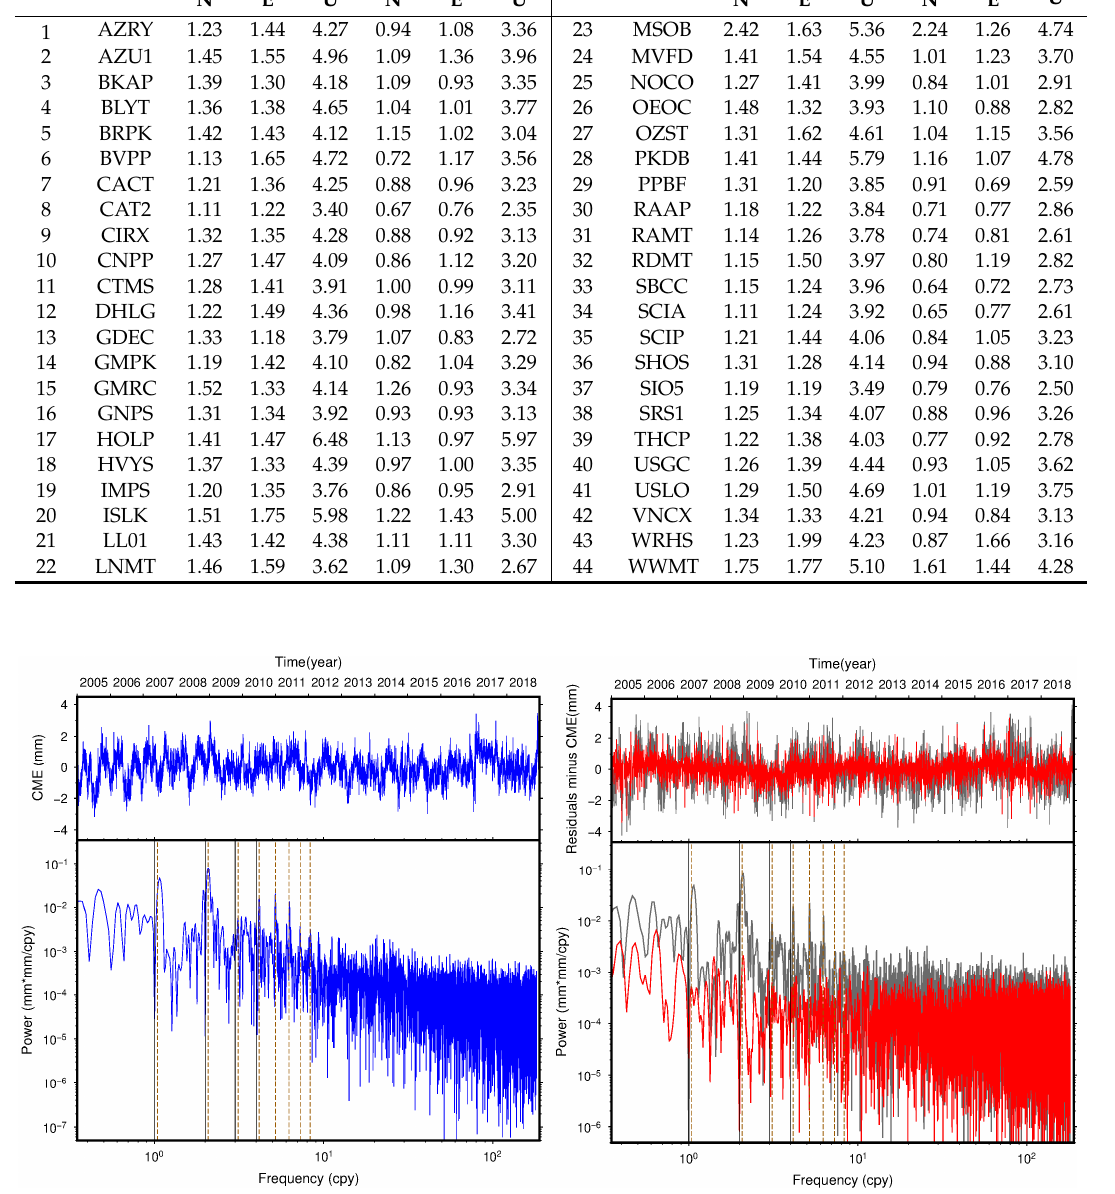
Table 5. RMS values of the 44 GNSS residual time series before and after removing CME (unit: mm). No.